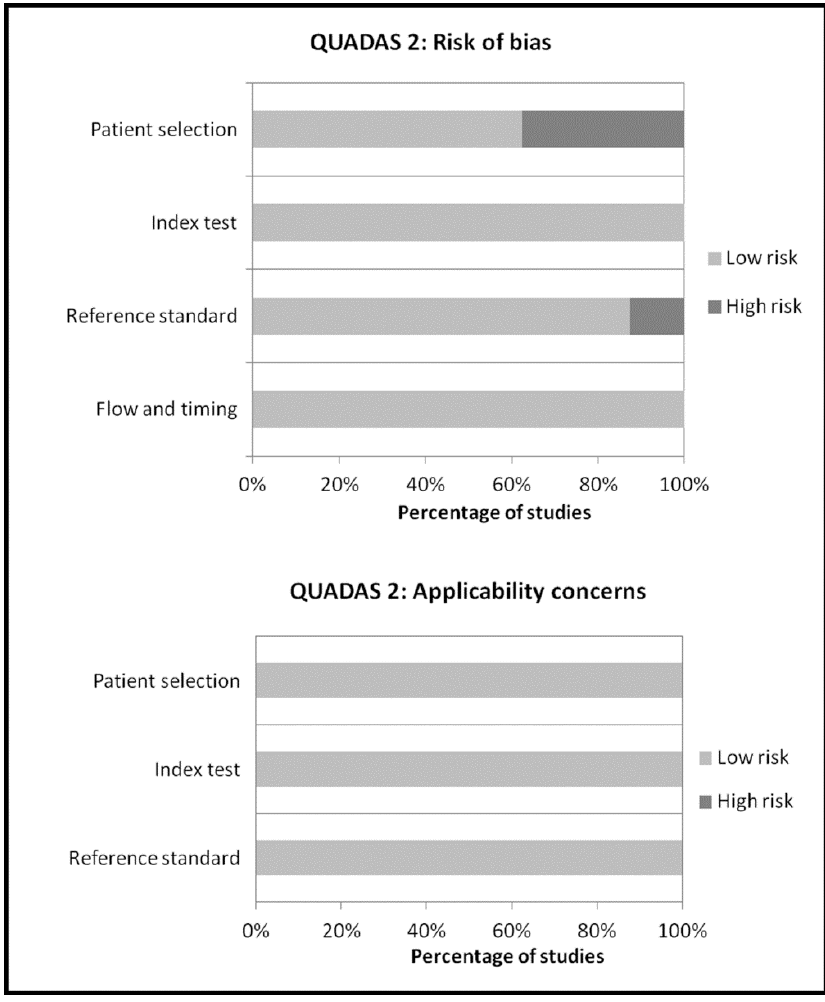
Figure 2. Overall quality assessment of the studies included in the systematic review according to Quality Assessment of Diagnostic Accuracy Studies (QUADAS-2)